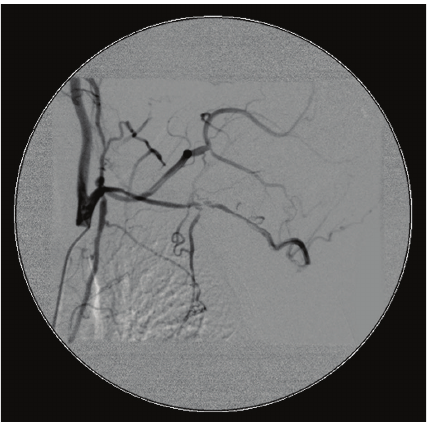
Figure 1: Angiography demonstrating severe stenosis of the aortic branches and complete occlusion below the level of the mesenteric artery.